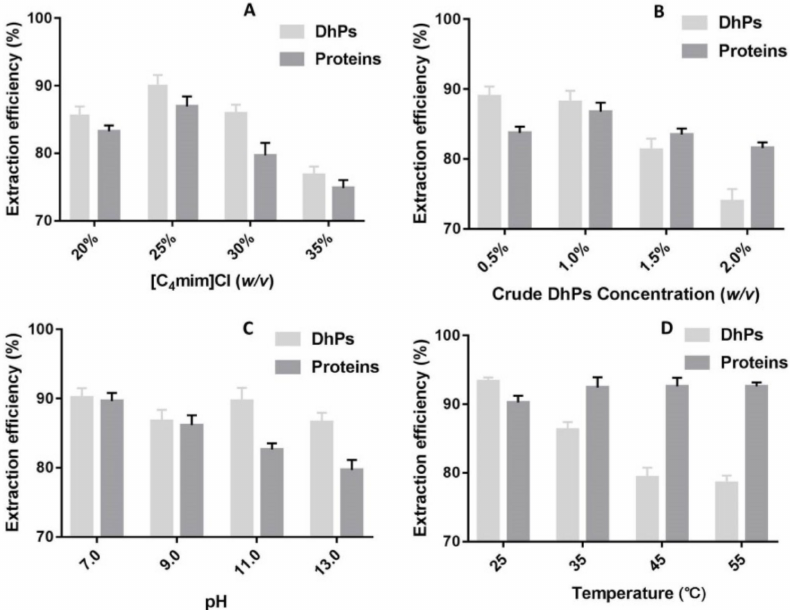
Figure 2. Determination of optimal quantity of [C 4 mim]Cl ( A ), crude DhPs concentration ( B ), pH value ( C ) and temperature ( D ) using the ILATPS system for extraction of polysaccharides and proteins from crude DhPs. All data in Figure 2 are presented as mean with SD and n = 3 per